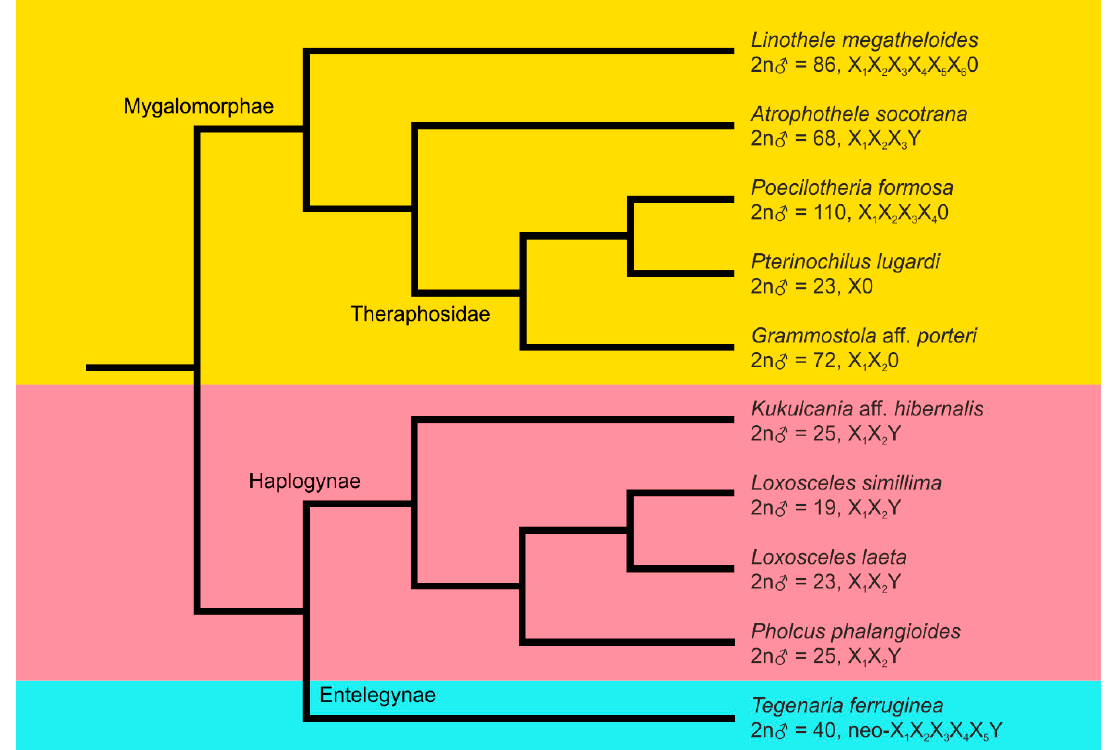
Figure 5. Phylogenetic relationships and karyotype characteristics of inspected spider species. The simplified phylogenetic tree was constructed following Wheeler et al. [63] except for Theraphosidae [64]. See Fernandez et al. [65] for proposed times of divergence of major lineages. Lineages: Mygalomorphae (orange background), Haplogynae (pink background), Entelegynae (light blue background).